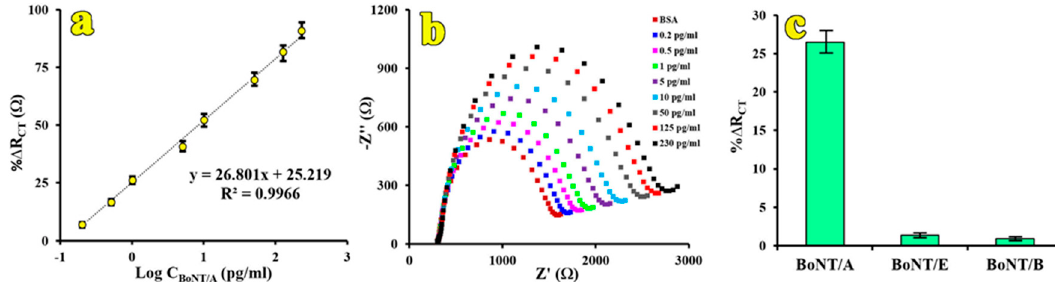
Figure 4. ( a ) Impedimetric immunosensor Nyquist plots and ( b ) Calibration curve (% ∆ R CT vs log C) for BoNT/A different concentration. ( c ) The performance of immunosensor in E and B serotype of BoNTs. (C BoNT/A = 1 pg·mL − 1 and C BoNT/E/B = 100 pg·mL − 1 ).